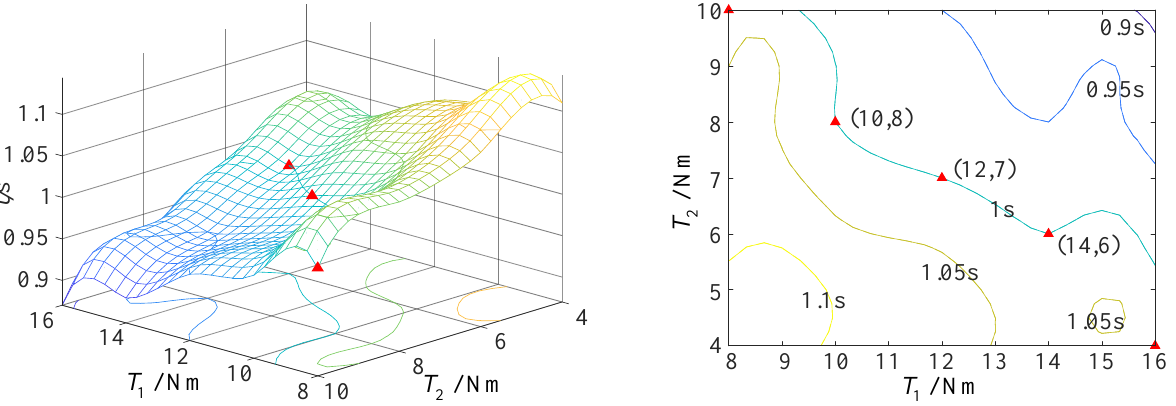
Figure 13. The curve of driving torque and deployment time of folding wing at an airspeed of 20 m/s (synchronous deployment mode).